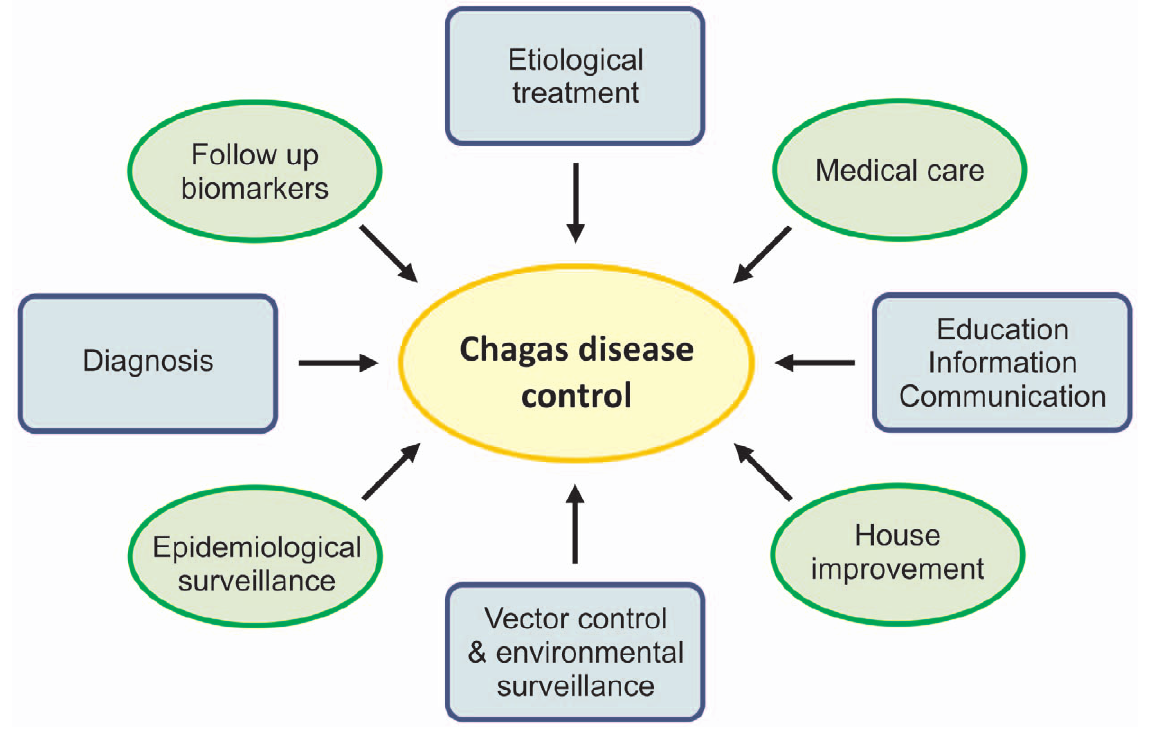
Figure 1. Chagas disease control: Hubs, challenges, and opportunities for the next decade.